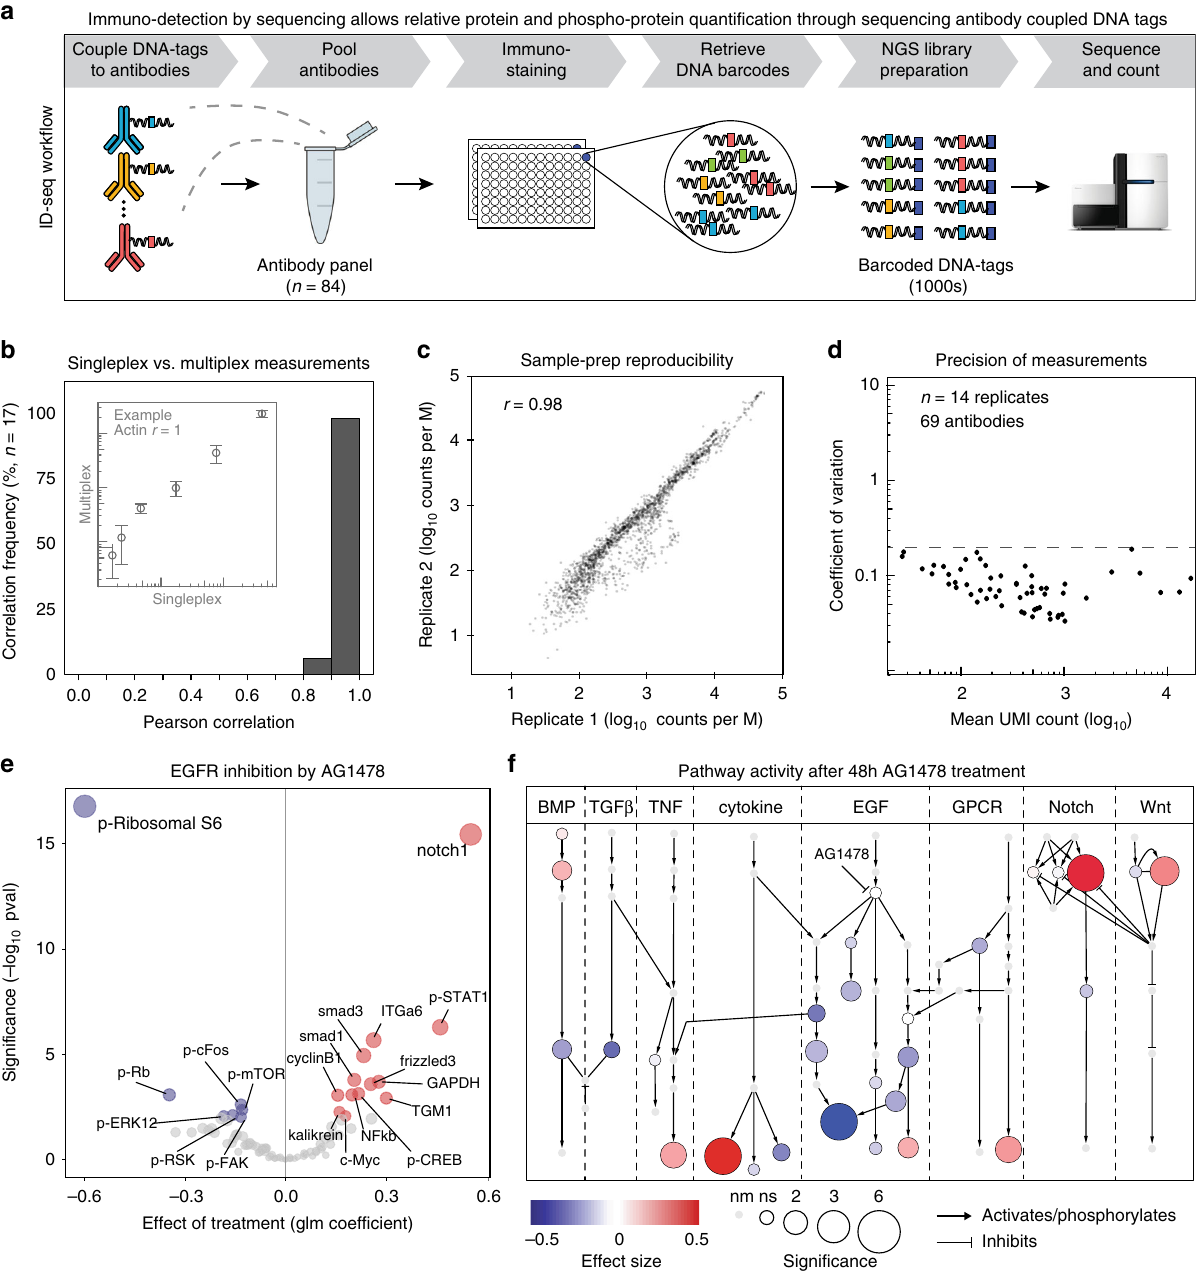
Fig. 1 Immuno-detection by sequencing (ID-seq) technology development. a Concept of the ID-seq technology. First, pool DNA-tagged antibodies. Second, perform multiplexed immunostaining on fi xed cell populations, and release DNA tags. Third, barcode the released DNA tags through a two-step PCR protocol. Finally, sequence the barcoded DNA tags via next-generation sequencing (NGS) and count barcodes. b Signals from singleplex epitope detection (via an immuno-PCR measurement) were compared with multiplexed epitope detection using ID-seq. The histogram summarises correlations between 17 immuno-PCR and corresponding ID-seq measurements. Insert panel illustrates an example from the actin antibody showing signal mean and s.d. ( n = 4). Underlying data for all 17 antibodies can be found in Supplementary Fig. 4. c Scatterplot indicates the high reproducibility of PCR-based ID-seq library preparation ( r = Pearson correlation). Libraries from the same released material were prepared on separate occasions and analysed in different sequencing runs. d The scatterplot shows the counts (mean) and coef fi cient of variation from 69 antibody – DNA conjugates ( n = 14 biological replicates). Dashed line indicates 20% variation. e Volcano plot shows the effect (estimate) and signi fi cance ( − log 10 pval) of AG1478 treatment ( n = 6), based on the model analysis of ID-seq counts (Supplementary Note 3). Signi fi cance ( − log 10 pval) determines node size. Red nodes show signi fi cantly increased (ANOVA, p < 0.01) and blue nodes show signi fi cantly decreased (ANOVA, p < 0.01) (phosphor-)protein levels. f Pathway overview of ID-seq measurements after 48 h of AG1478 treatment. Colour indicates the effect size and node size represents the signi fi cance of effect ( − log 10 pval). Light grey nodes without border indicate not measured (nm) proteins (see Supplementary Supplementary Fig. 12 for (phospho-)protein